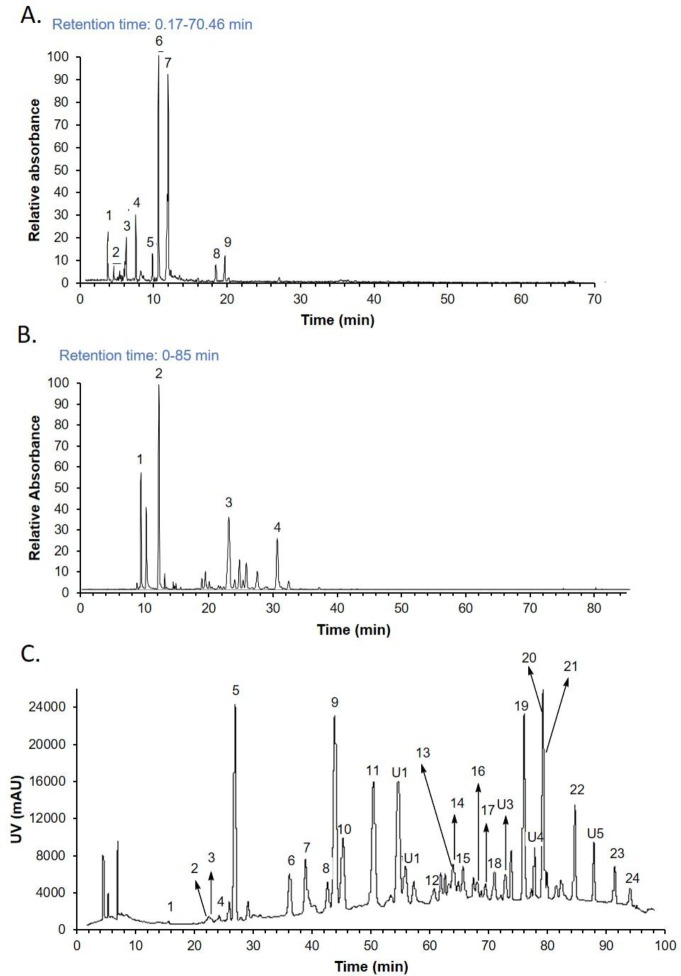
Chromatographic characterization of Cinobufatin components.A. total ionic chromatogram of nucleic acids. B. total ionic chromatogram of tryptamines. C. Ultraviolet diagram of bufotalins. Identification of peaks are shown in supplementary tables.